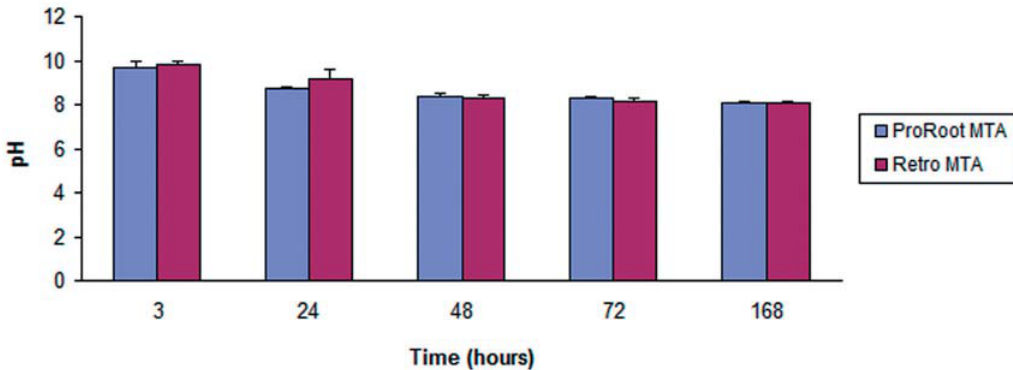
Figure 3- Results of pH analysis over time